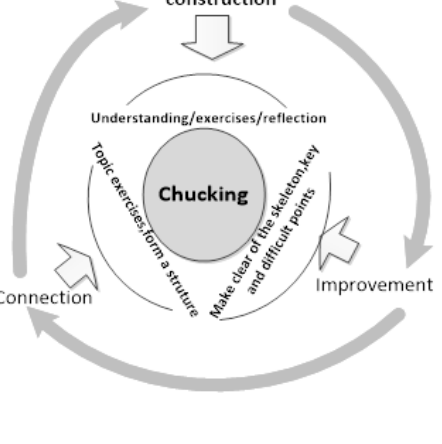
Fig. 3 Design of Mathematics Chunk